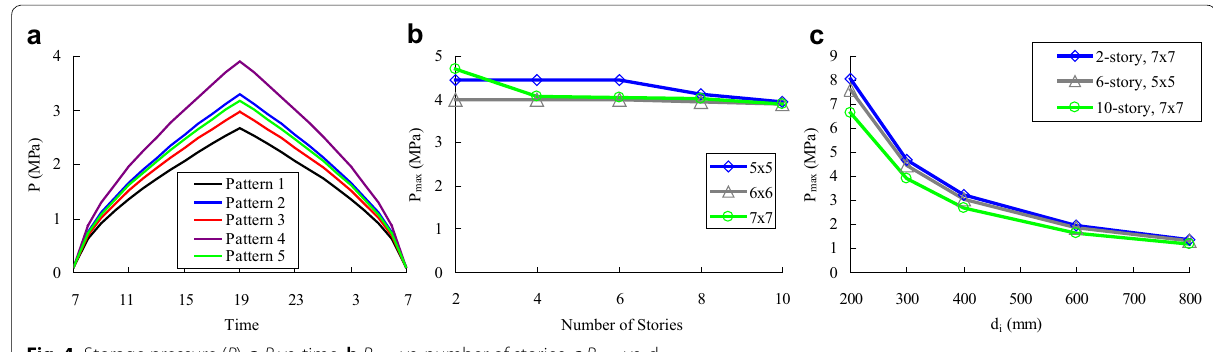
Fig. 4 Storage pressure ( P ): a P vs. time; b P max vs. number of stories; c P max vs. d i